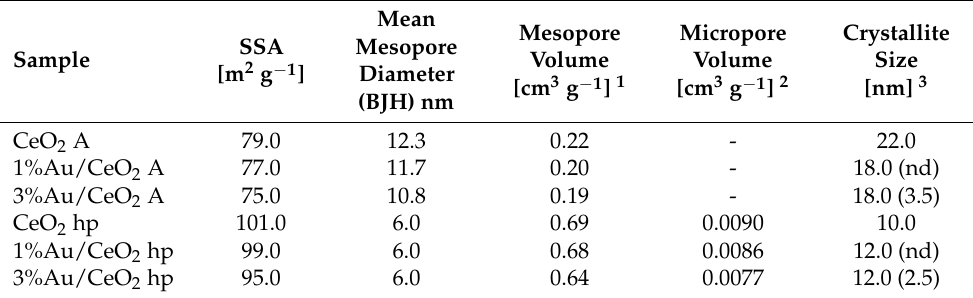
Table 1. Textural properties of ceria oxides and Au supported